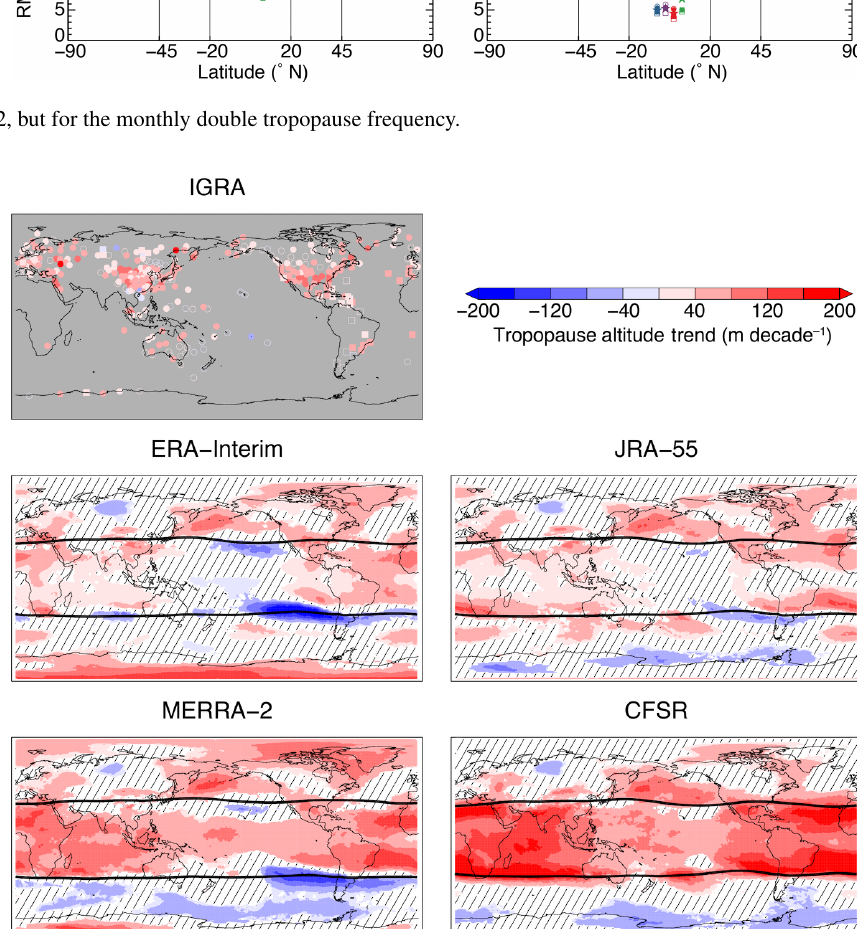
Figure 4. Eulerian mean trends of the primary tropopause altitude from 1981 to 2015 for IGRA radiosonde observations and the reanalyses. For IGRA trends, circles denote 00:00UTC trends and squares denote 12:00UTC trends, with filled symbols denoting statistical significance. Colored areas of the reanalysis maps are statistically significant, while line-filled regions are not. Thick black lines in each reanalysis map show the 35-year mean tropopause break